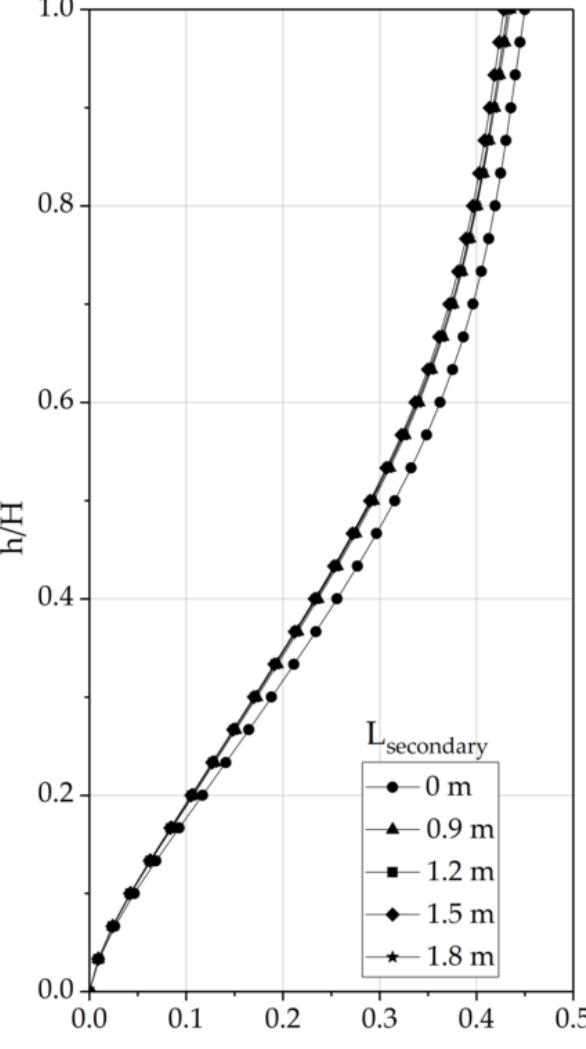
Figure 11. The e ff ect of the length of the secondary reinforcement on the relative lateral Figure 11. The effect of the length of the secondary reinforcement on the relative lateral facing facing displacement.